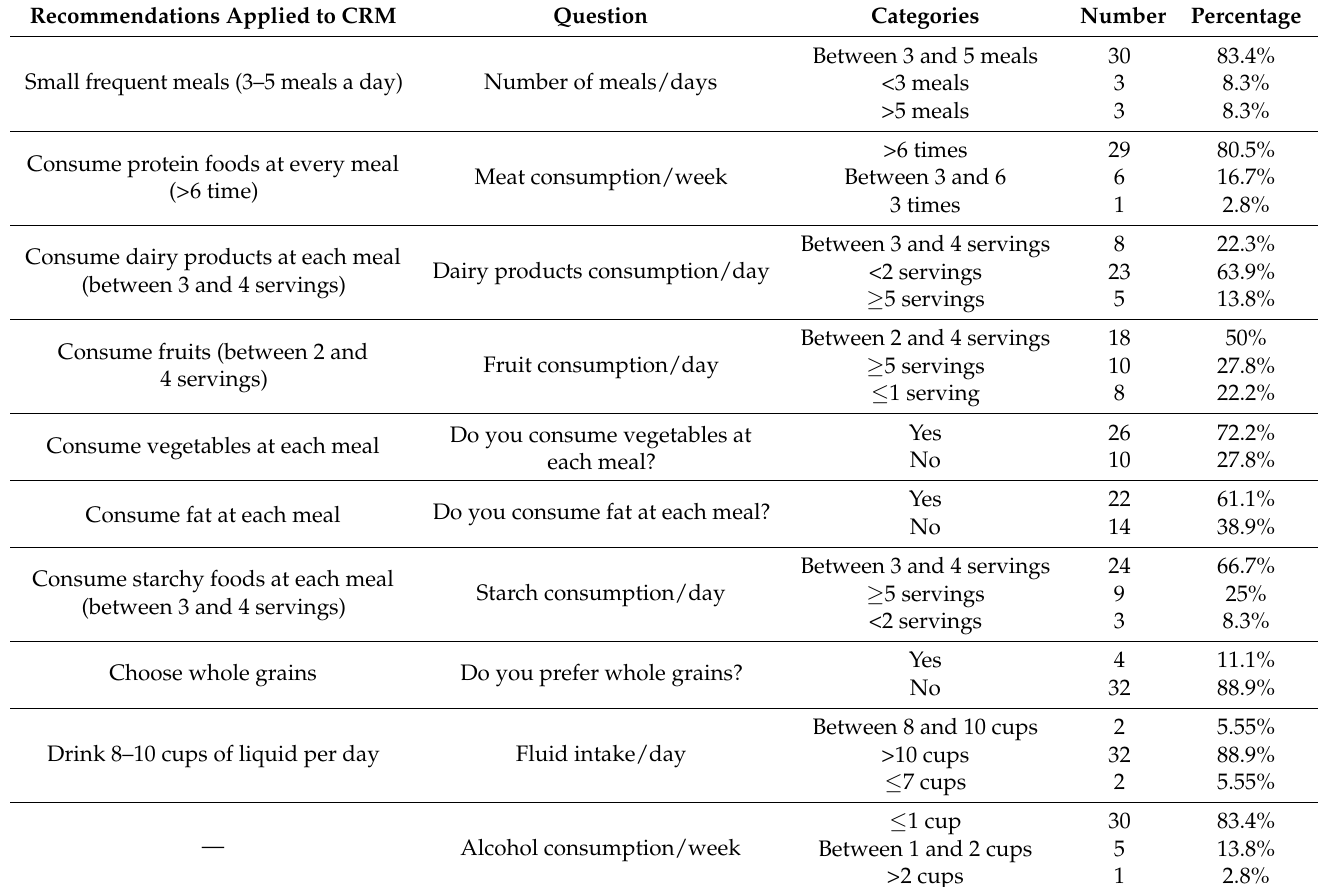
Table 6. Recommendations provided during post-COVID-19 rehabilitation compared to dietary habits at 6 months after